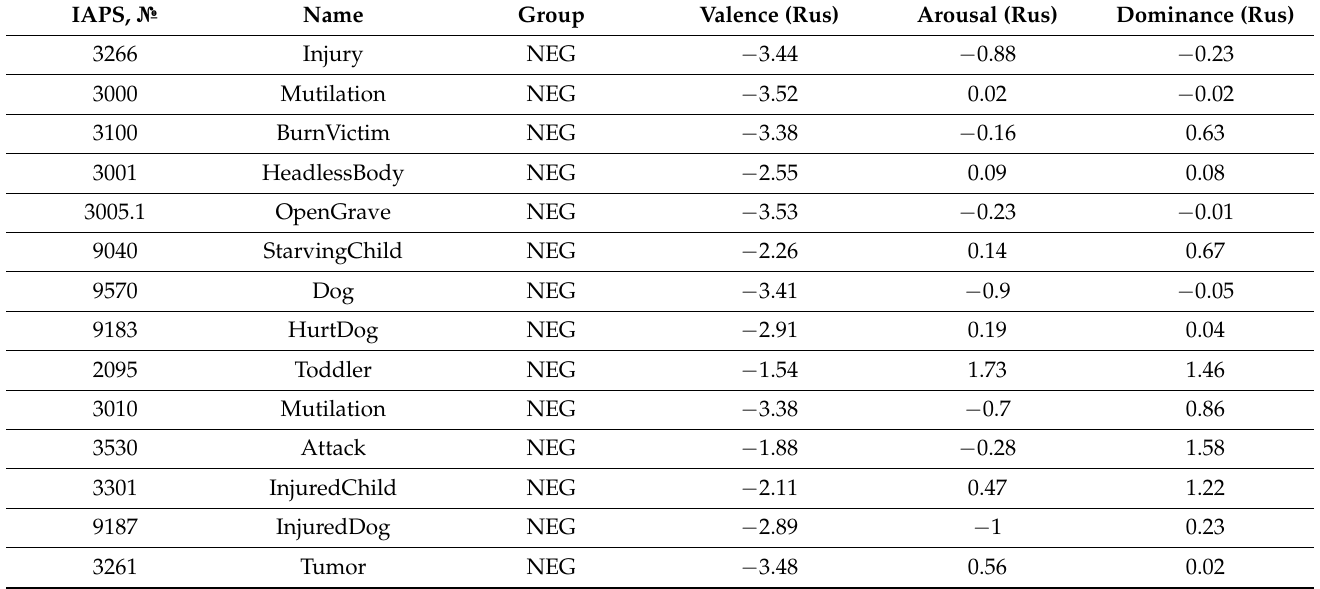
Table A2. Responses of subjects according to the SAM questionnaire to stimulus material from the IAPS database based on a Russian